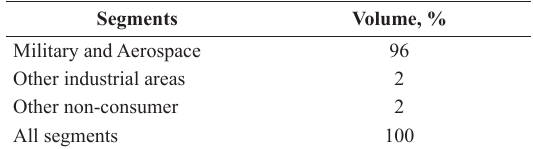
Figure 4. Commercialized TMs 30 . Table 1. World market of TEGs (in 2012) 32